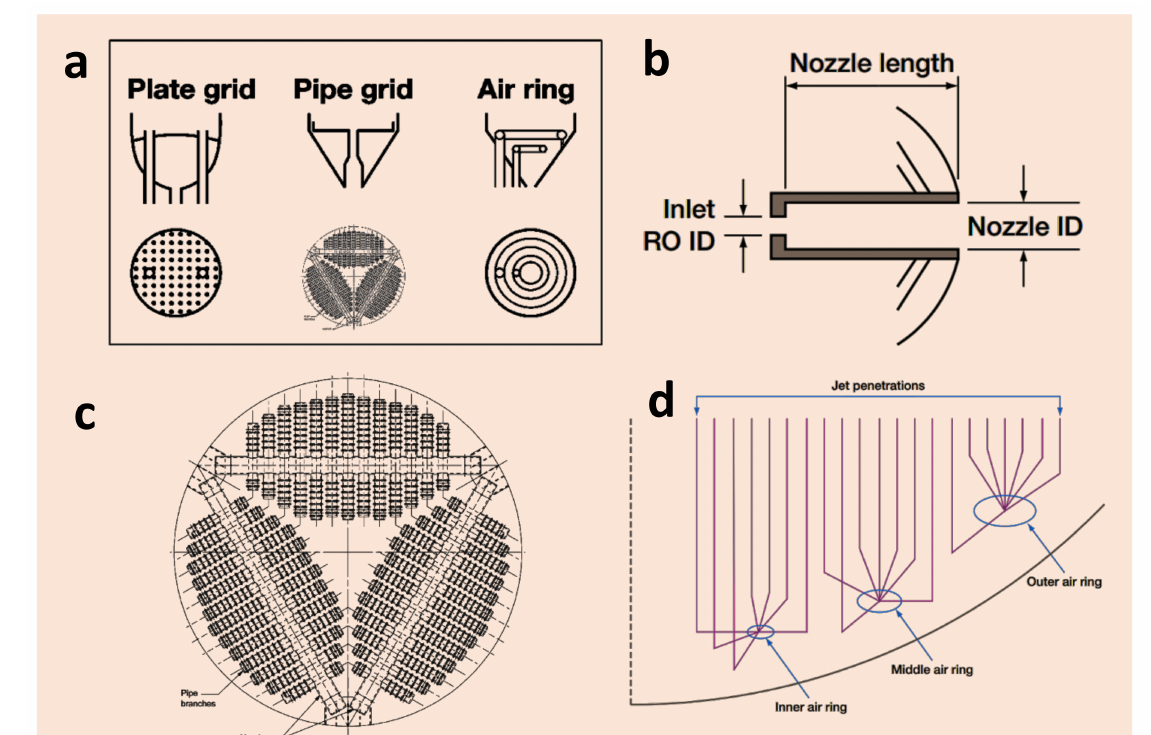
Figure 7. Air distributor design. ( a ) Different grid configurations; ( b ) nozzle design; ( c ) pipe grid part; ( d ) ring jet arrangement. Adopted from Sadeghbeigi [19] and Cooper